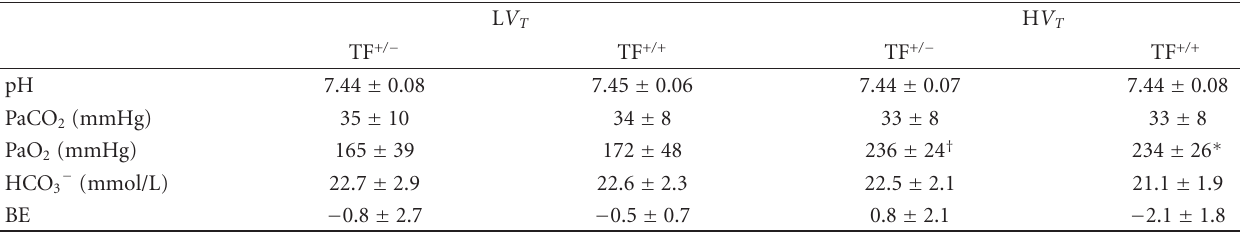
Table 1: Arterial blood gas analysis after 5 hours of mechanical